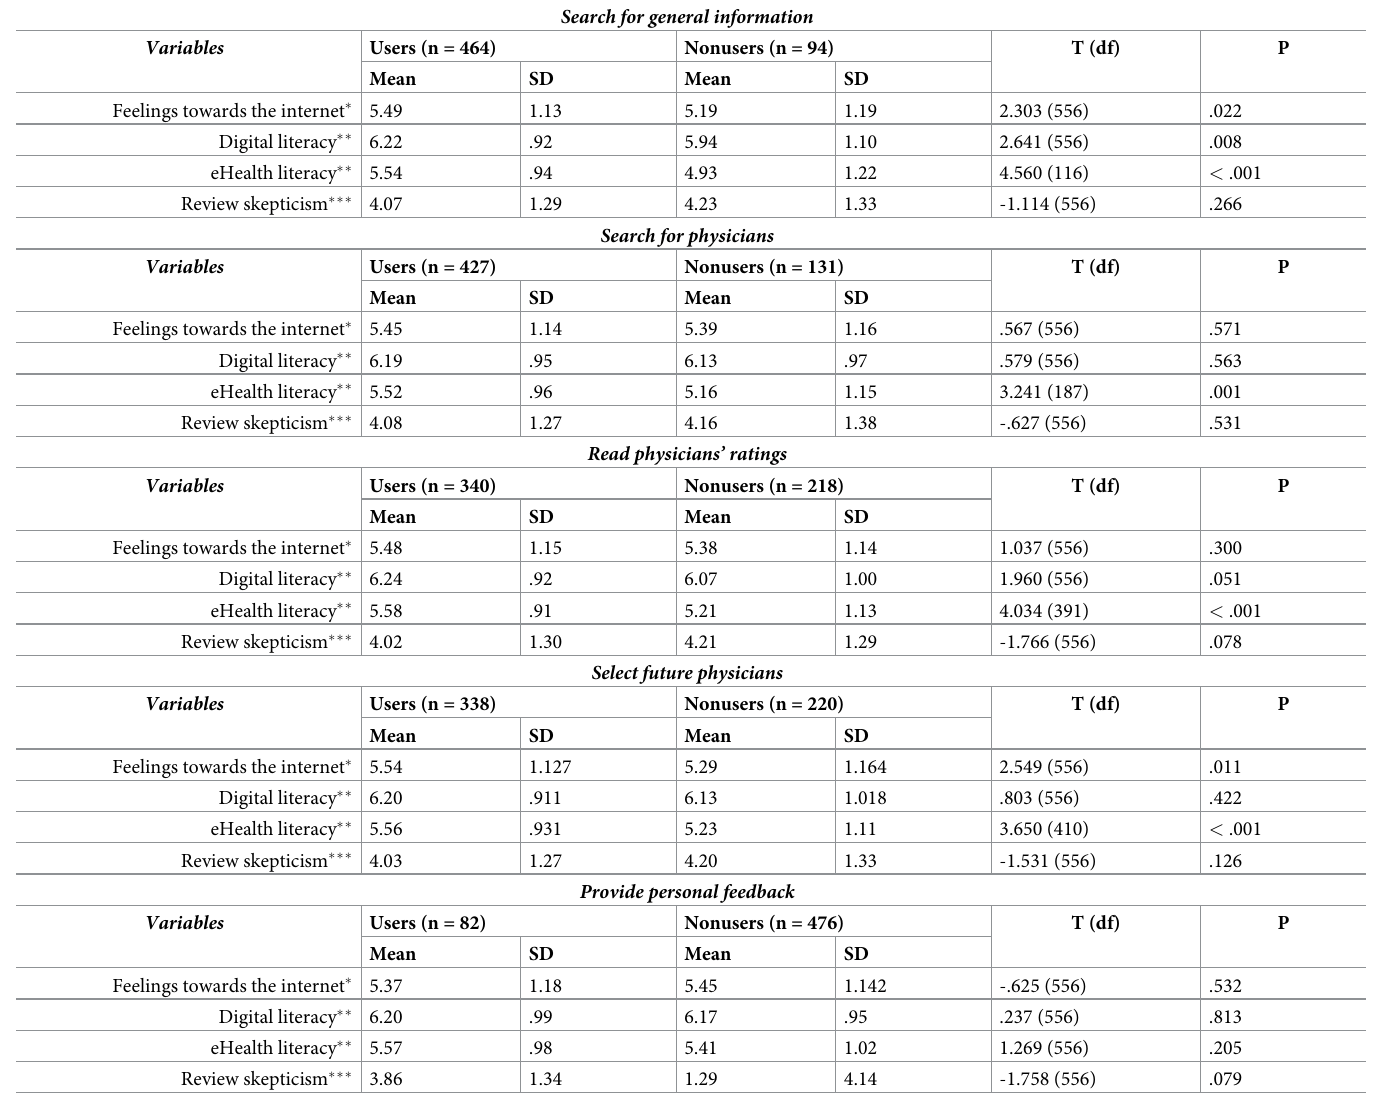
Table 8. Types of interaction with PRWs and association with psychographic